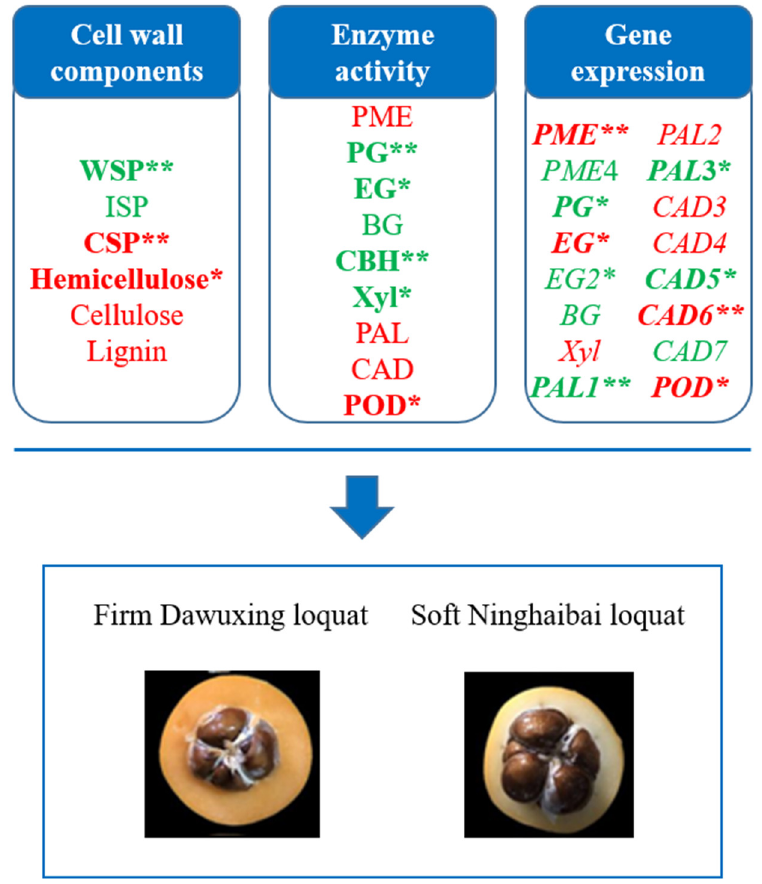
Figure 5. Schematic summary of the important factors influencing loquat fruit firmness. The bold represents statistically significantly related to loquat fruit firmness. The red and green represent positively and negatively correlated factors to loquat fruit firmness. * denotes p < 0.05; ** denotes p <